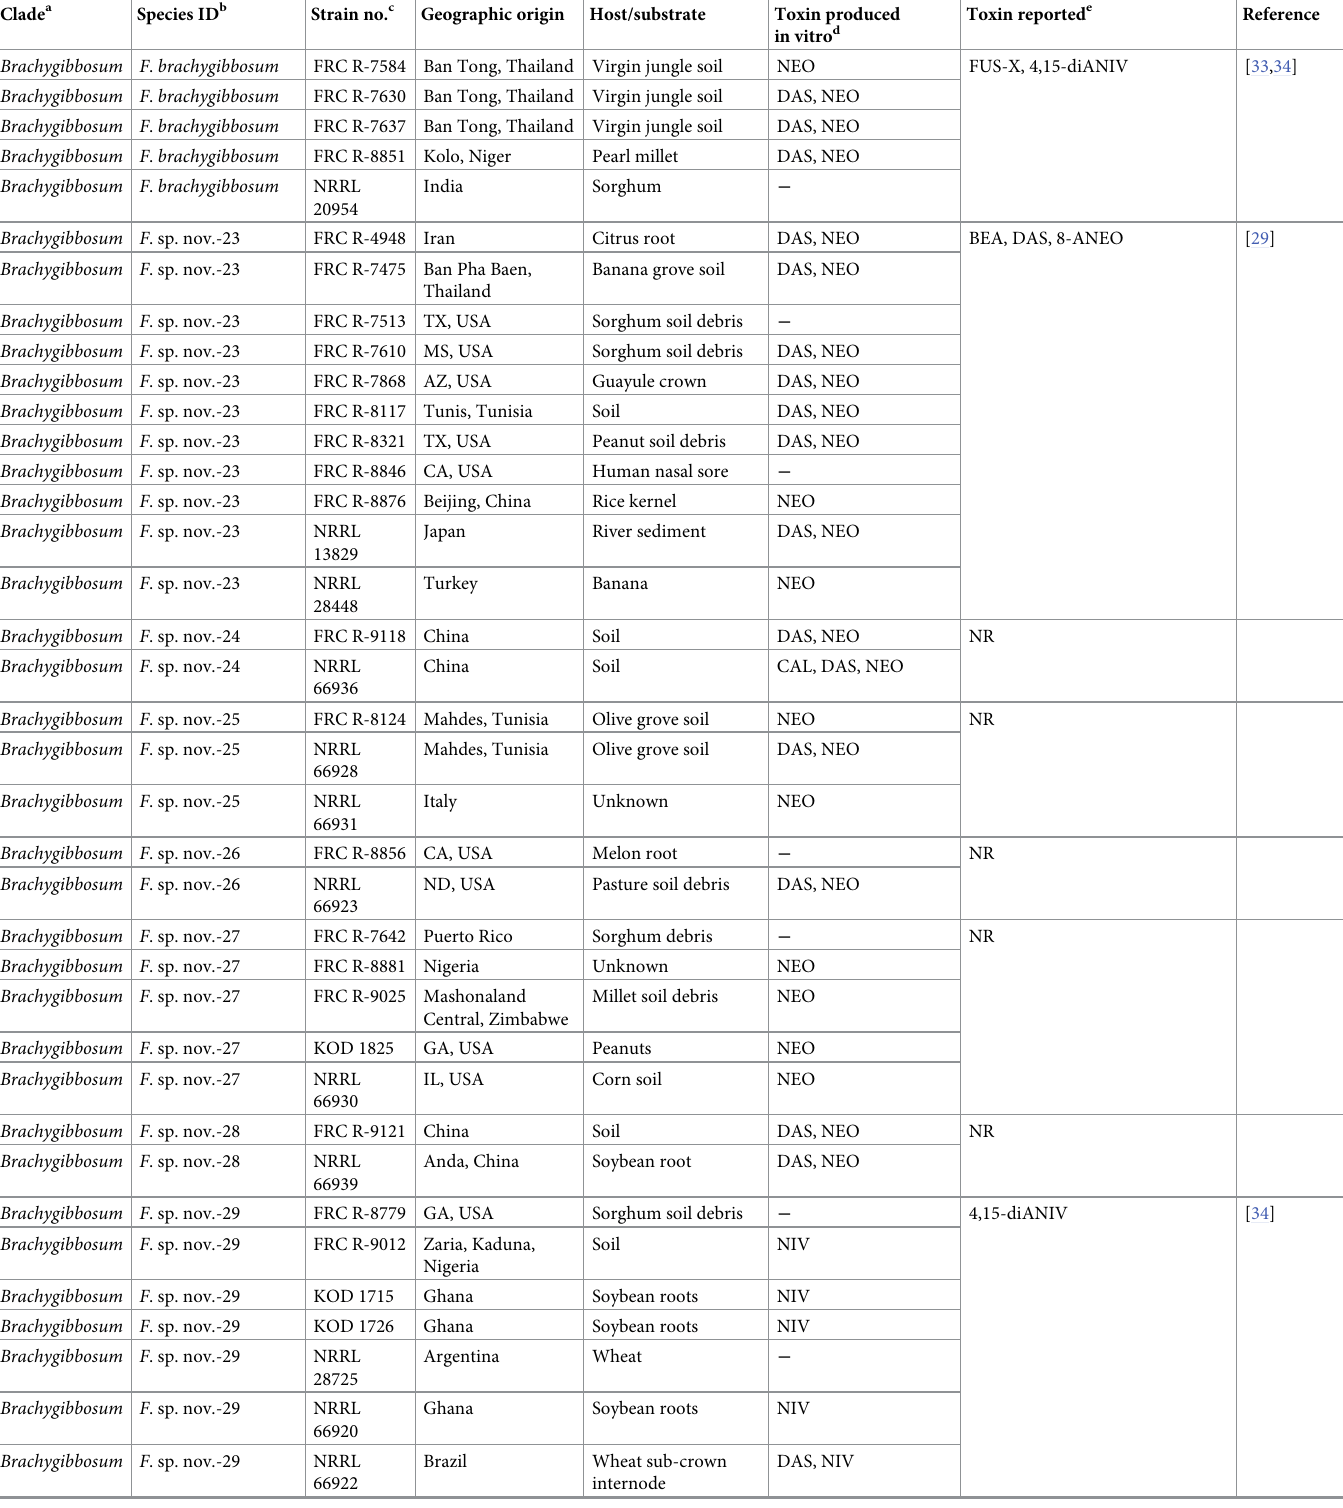
Table 1. Fusarium sambucinum species complex strains used and toxins produced in present study and reported in the literature. Clade a Species ID